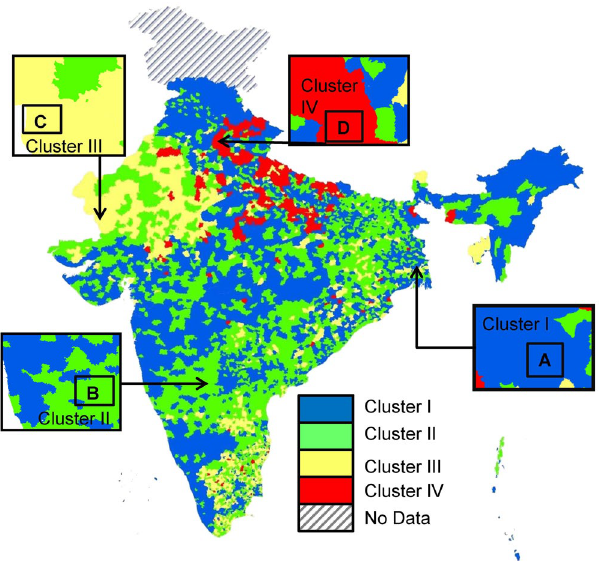
Figure 6. Map of the study area showing the four clusters, showing Cluster I (superset of detailed study area A) blocks (3069 BLKs, i.e. 44% of entire study region) where Water Quality and Health (WQH) alleviation are predominantly influenced by Sanitation and Economic development (DEV), and Improper Human Practices (IHP) has minimal influence, within the study period; Cluster II (superset of area B) blocks (1596 BLKs, 23%), where DEV influence WQH, but IHP has some effect; Cluster III (superset of area C) blocks (631 BLKs, 9%), where IHP influence WQH, but DEV has some effect; and Cluster IV (superset of area D) blocks (1714 BLKs, 24%), where IHP predominant influence on WQH, but DEV has minimal